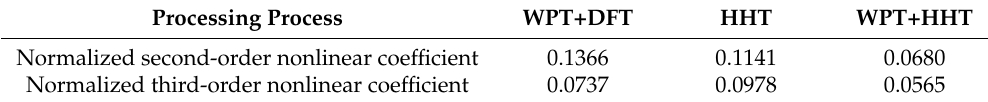
Table 1. Mean squared error of different processing